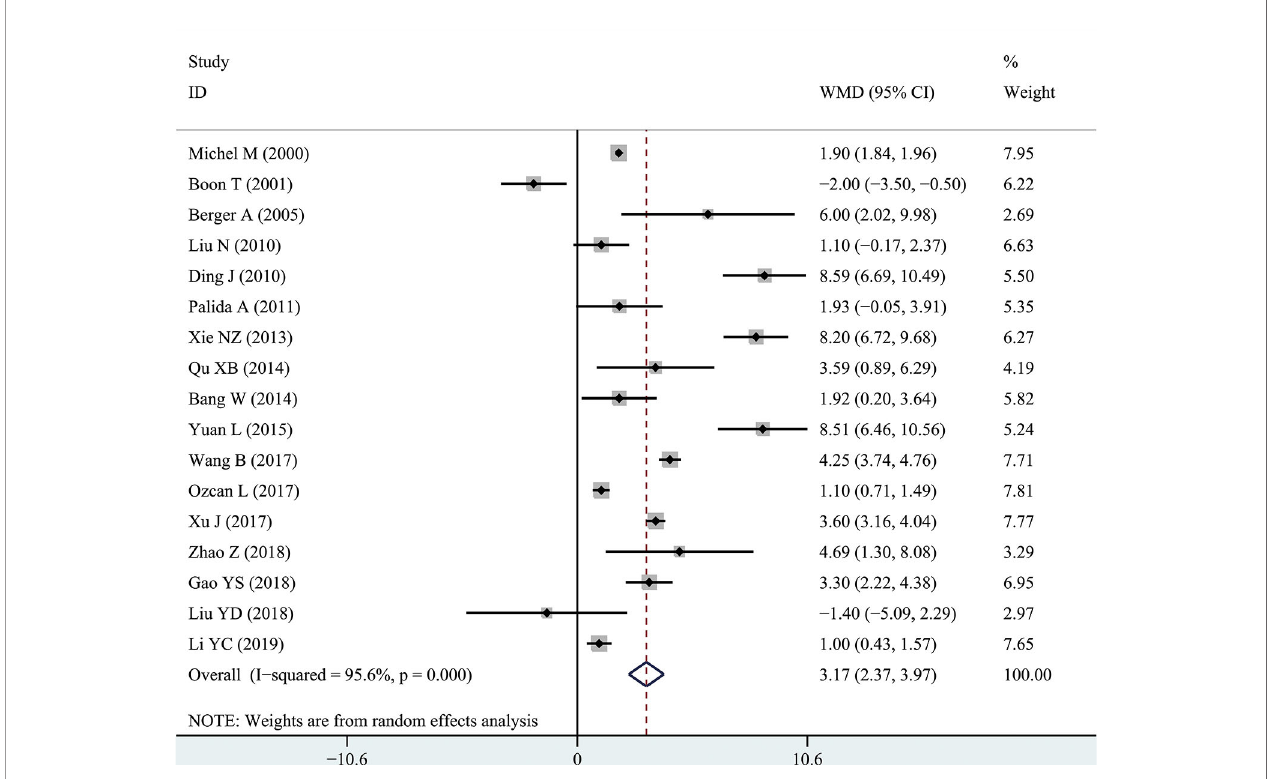
FIGURE 2 | Forest plots of International Prostate Symptom Score comparing diabetes group to without diabetes group in benign prostatic hyperplasia patients. The diamond represents the pooled Weighted Mean Difference (WMD) and 95% con fi dence intervals